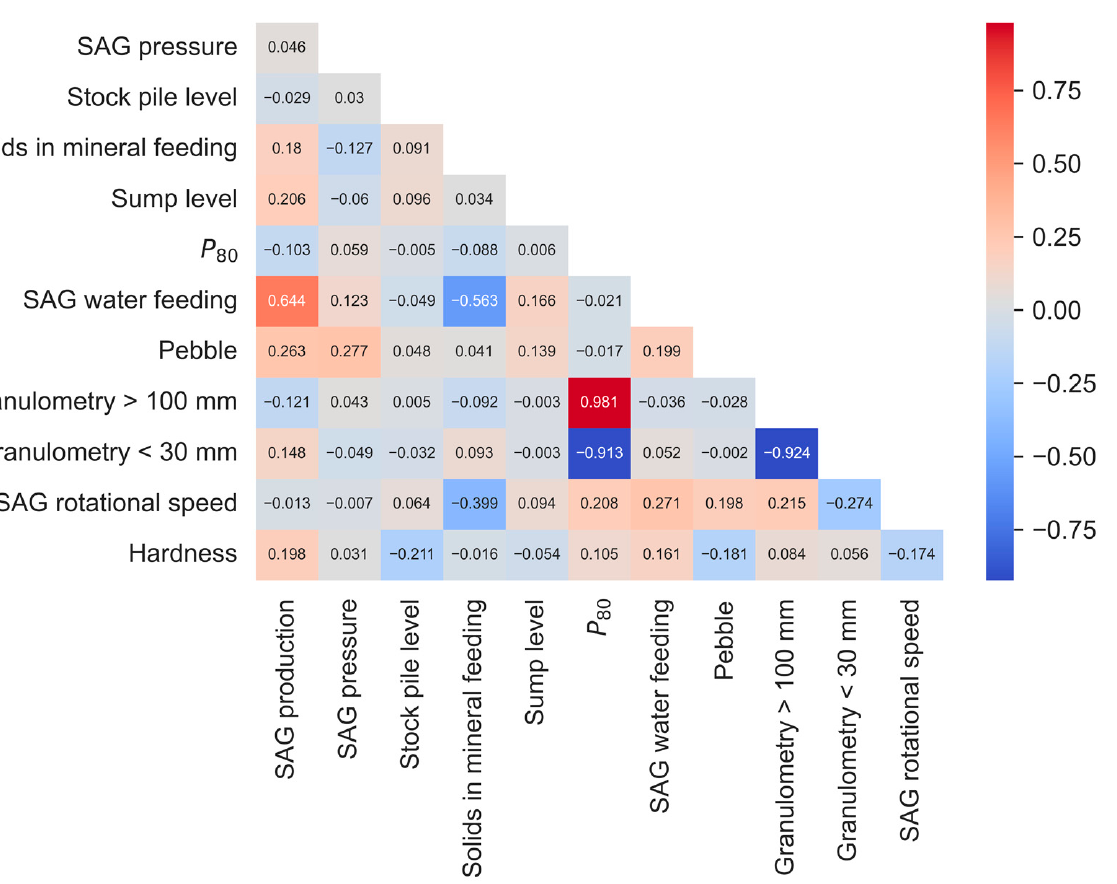
Figure 3. A Spearman correlation of the operational variables of an SAG grinding system.